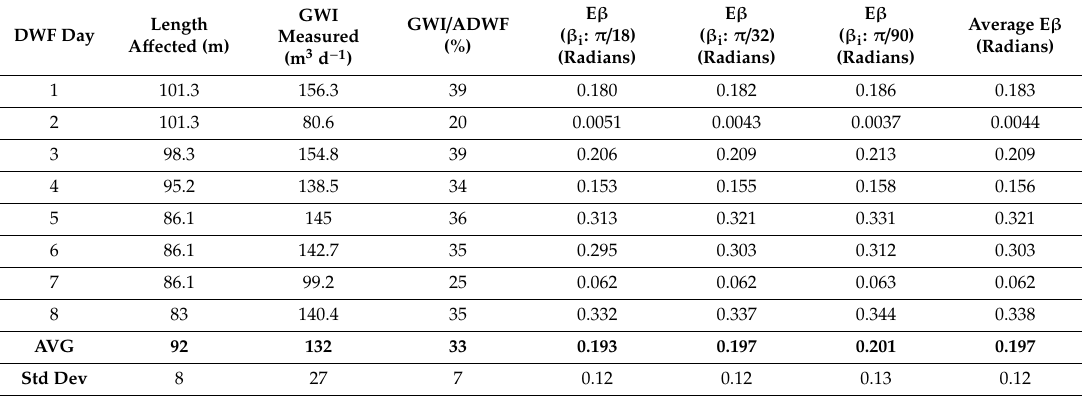
Table 2. Measured GWI and e ff ective β calibration for each dry weather flow